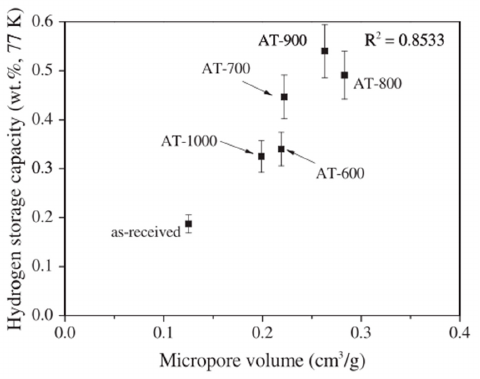
Figure 4. Hydrogen adsorption capacities of p-type MWCNTs with different acid-mixed treatments, where Acid-1 is H 2 SO 4 , Acid-2 is H 2 SO 4 :H 2 O 2 = 3:1, Acid-3 is H 2 SO 4 :H 2 O 2 = 1:1, Acid-4 is H 2 SO 4 :H 2 O 2 = 1:3, Acid-5 is H 2 O 2 [80].